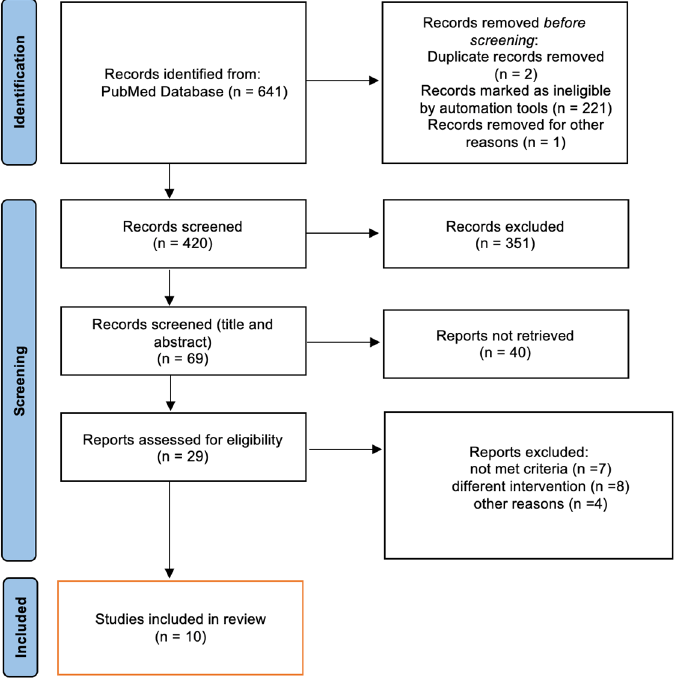
Figure 1. The fl ow diagram of the literature review process. Figure 1. The flow diagram of the literature review